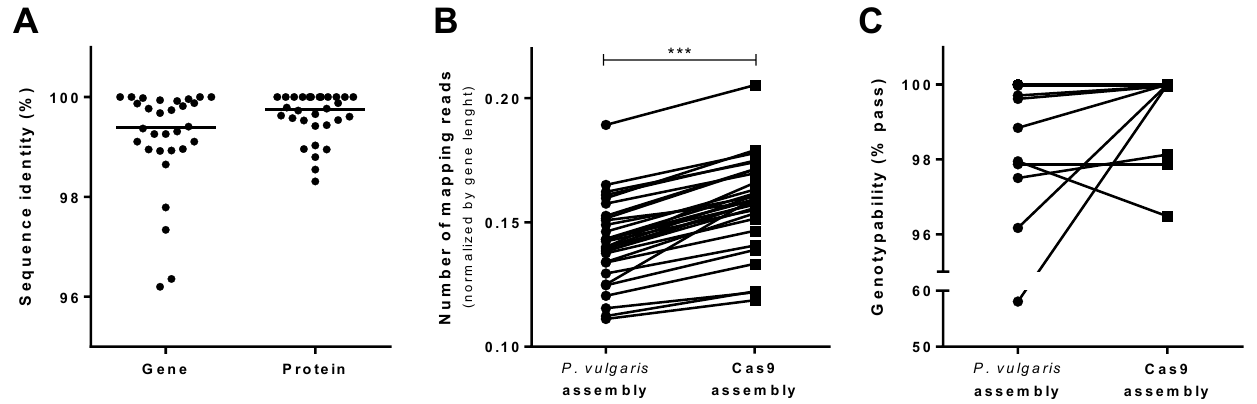
Figure 4. Comparison of sequences and mapped reads of orthologous genes in the P. vulgaris refer- ence genome and Cas9 assemblies. ( A ) Percentage sequence identity of the orthologous genes and corresponding proteins derived from the P. vulgaris reference genome and Cas9 tiling assembly (ex- cluding untranslated regions, which were not annotated de novo in the Cas9 assembly). ( B ) Number of Midas WGS Illumina reads mapping onto the orthologous genes from the P. vulgaris reference genome and Cas9 tiling assembly, after normalizing by each gene length. ( C ) Proportion of bases that can be genotyped (% PASS at ≥ 5 reads) in the orthologous genes from the P. vulgaris reference genome and Cas9 tiling assembly. *** p -value < 0.0001, paired t